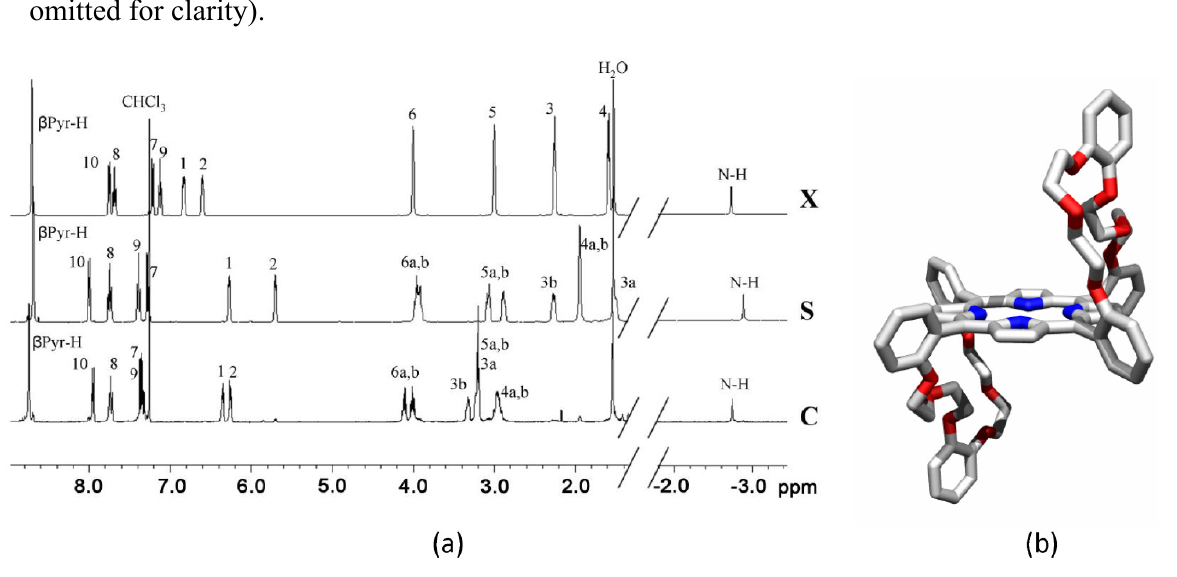
Figure 1. ( a ) 1 H-NMR spectra (400 MHz) of “basket handle” porphyrin isomers X , S and C in CDCl with proton assignments based on COSY and 2D-ROESY NMR 3